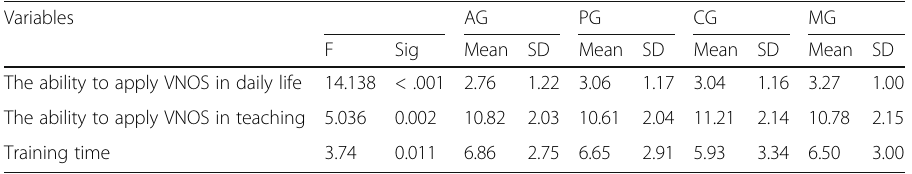
Table 4 NOS knowledge application ability and training time for each group Variables AG PG CG MG F Sig Mean SD Mean SD Mean SD Mean SD The ability to apply VNOS in daily life 14.138 < .001 2.76 The ability to apply VNOS in teaching